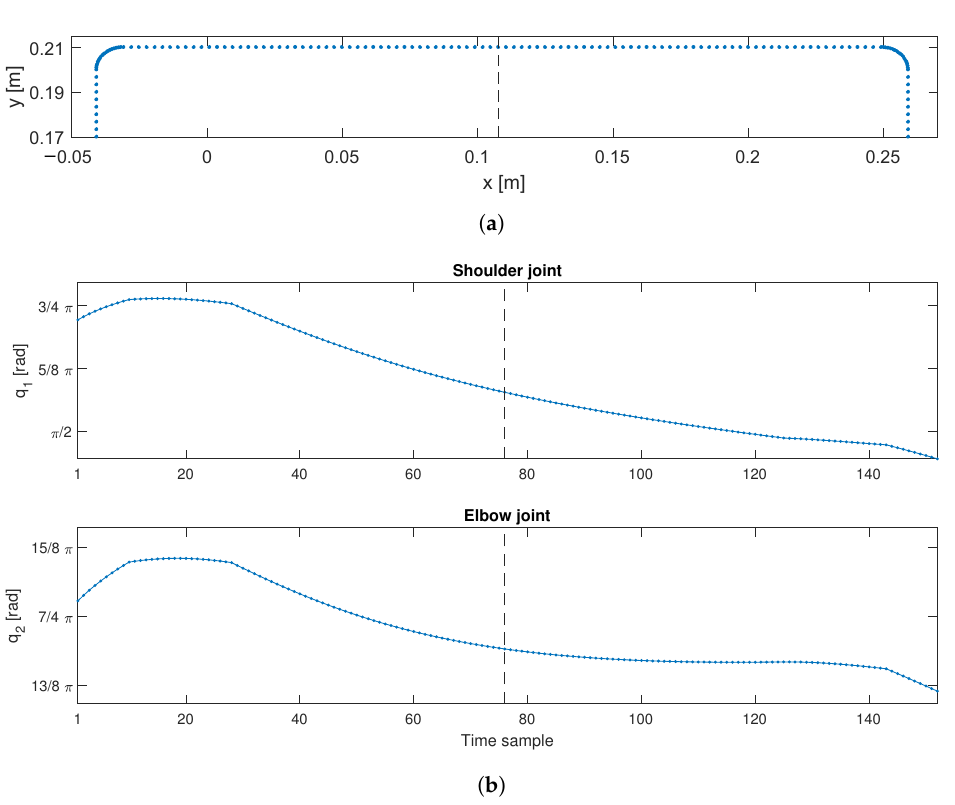
Figure 2. Trajectory of the flexible linkage: ( a ) end-effector trajectory in the work space; ( b ) joint space